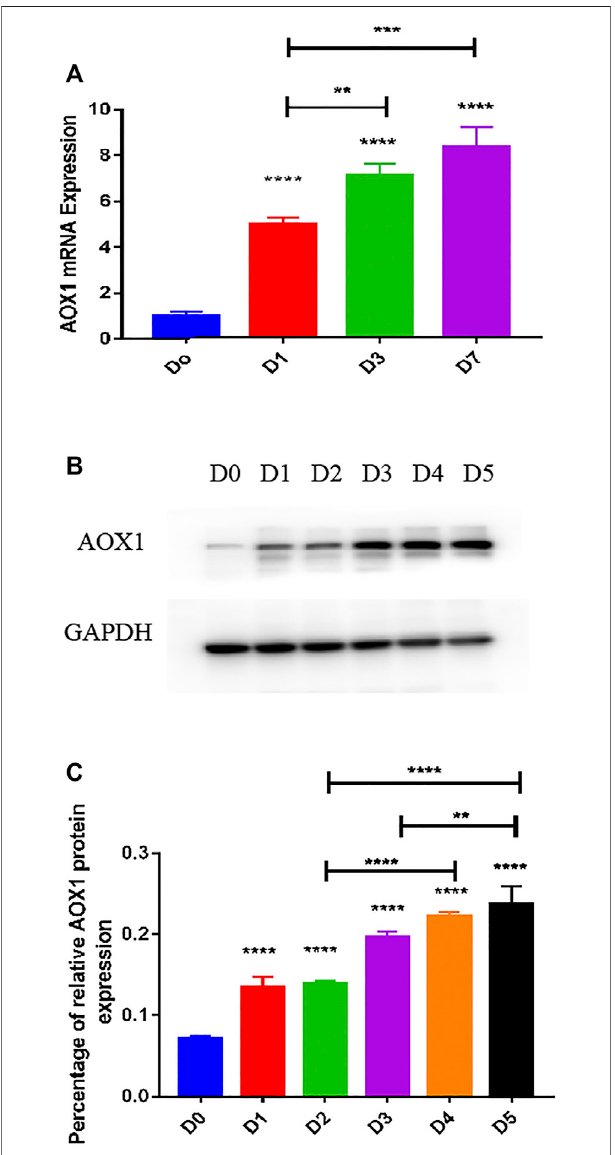
FIGURE 6 | Endogenous AOX1 mRNA expression and the endogenous AOX1 protein expression on osteogenic differentiation of hBMSCs. (A) Endogenous expression of AOX1 mRNA was determined by qPCR at days 0, 1, 3, and 7 of osteogenic differentiation. (B) Endogenous expression of AOX1 protein was determined by Western blotting analysis at days 0, 1, 2, 3, 4, and 5 of osteogenic differentiation (C) Relative quantitative analysis of Western blot analyses for AOX1, data are used by percentage and expressed as the mean ± SD.